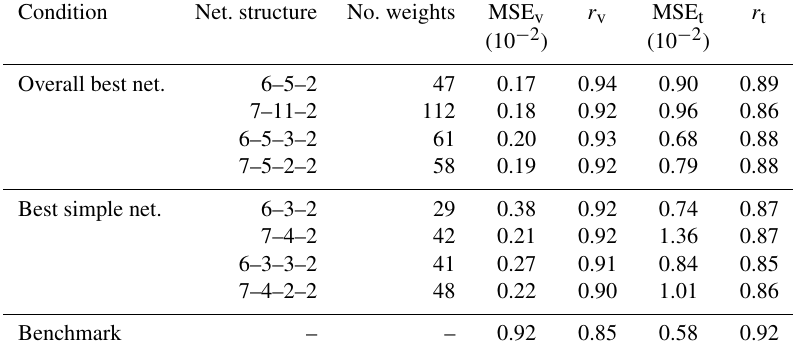
Figure 4. The validation MSE of trained networks using a station-wise data split as a function of the hidden layer size for (a) the network with six inputs and one hidden layer (left), and (b) the network with seven inputs and two hidden layers (right). The numbers on the bottom axis of (b) indicate the number of neurons in the first (top row) and second (bottom row) hidden layer. Values for the other networks considered are similar. Whiskers indicate the length of interquartile range, and each box summarises the results from 750 single networks. Table 4. Performance results of the overall best network and the best simple network. MSE and r are measured on normalised data and are non-dimensional. MSE v and r v are calculated on validation data, and MSE t and r t are calculated on test data. The performance of the MOST method (the “Benchmark”) is also shown. Condition Net. structure